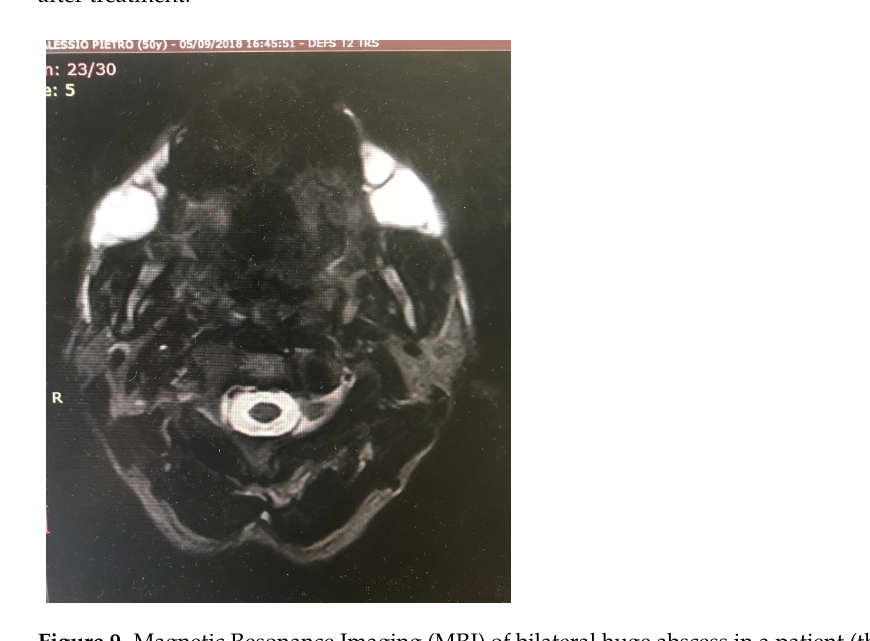
Figure 10. MRI of Caucasian male patient from Figure 8 showing bilateral collection of semi-fluid material. Only these three patients were followed up for 9 years, due to the complications de- veloped.